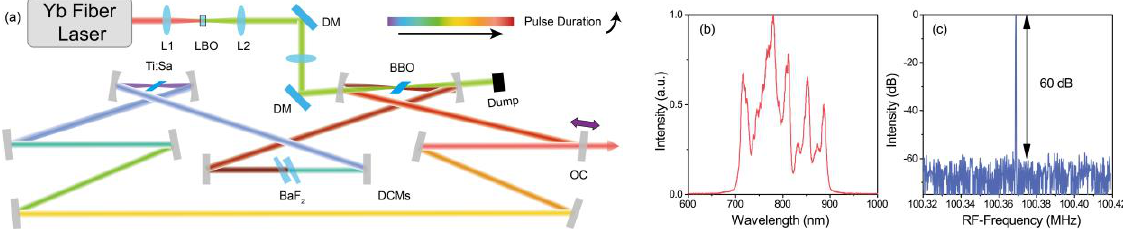
Fig. 1 (a) Schematics illustration of the experimental set-up. L1 and L2: lens; DM: dichroic mirror; DCMs: double- chirped mirror pairs; OC: output coupler. (b) Measured output spectrum (c) Radio-frequency spectrum over a 100 kHz span with 100 Hz